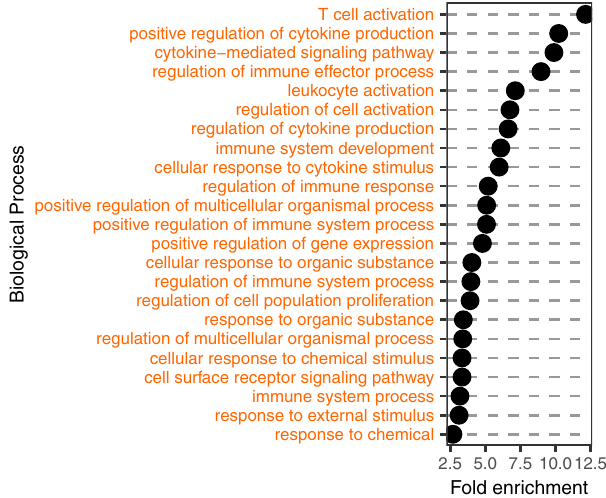
Fig.5|BiologicalpathwaysenrichedforgenesaffectedbydiseaseeQTLsunder selection. Enrichment of eQTL target genes in GO Biological Process annotation dataset (10.5281/zenodo.639996 Released 2022-03-22) is based on PANTHER Overrepresentation Test 77 . Source data are provided as a Source Data fi